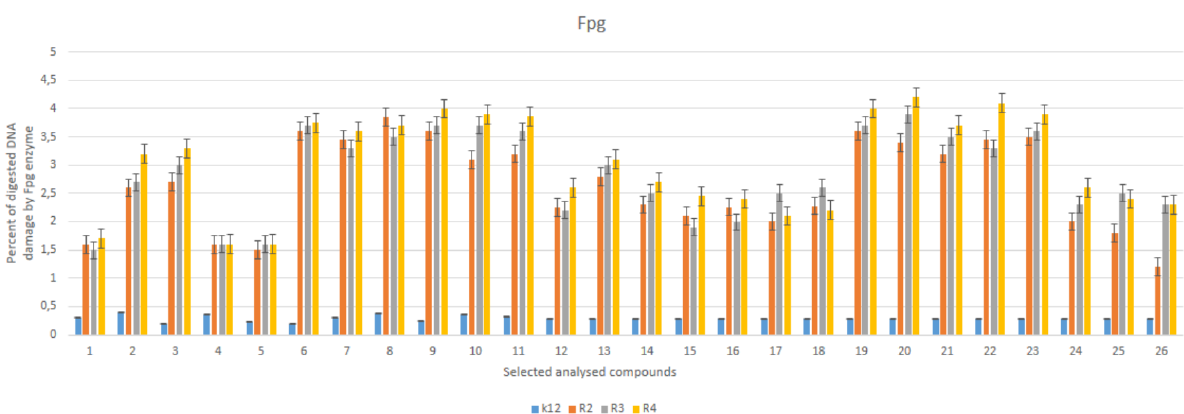
Figure 6. Percentage of plasmid DNA recognized by Fpg enzyme ( y -axis) with model bacterial, K12, and R2–R4 strains ( x -axis). The compounds numbered 2 , 3 , 6 , 7 , 8 , 9 , 10 , 11 , 13 , 19 , 20 , 21 , 22 , 23 were statistically significant at <0.05 * (see Table 1). Each experiment was performed independently in 3 replications ( n = 3).